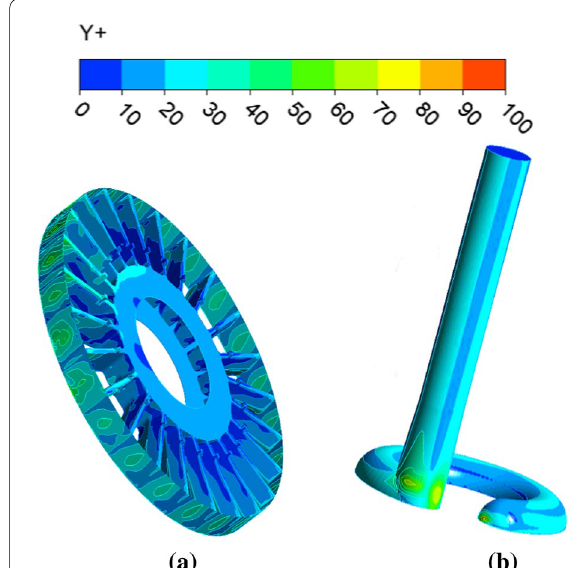
Figure 3 Y distribution ( a ) impeller, ( b ) side channel +